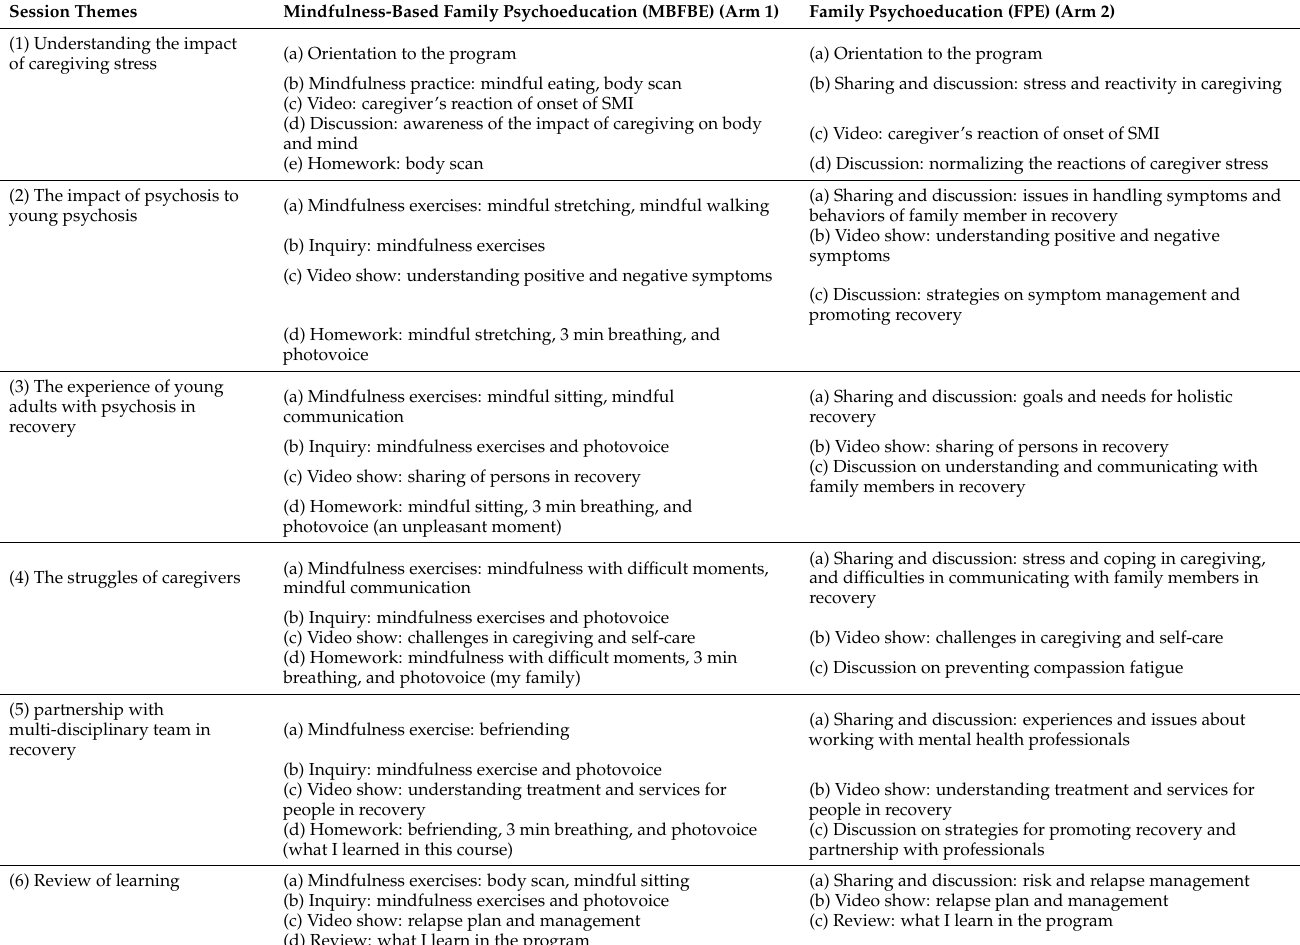
Table A1. Brief outline of mindfulness-based family psychoeducation (MBFPE) (arm 1) and family psychoeducation (FPE) (arm